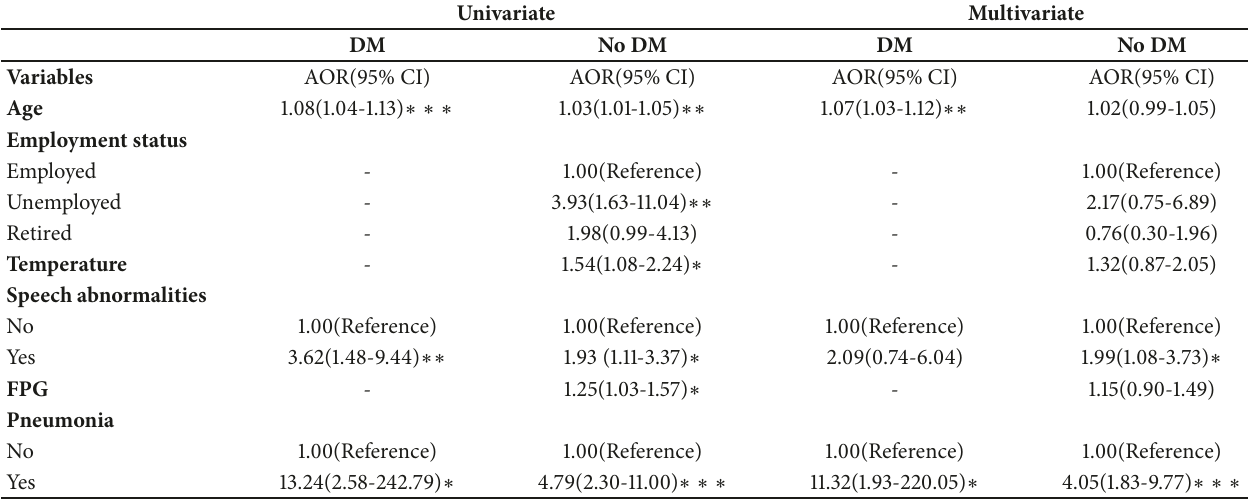
Table 5: Factorsassociated with functional outcome at 6 months for stroke patients with and without diabetes on univariate and multivariate logistic regression analysis.